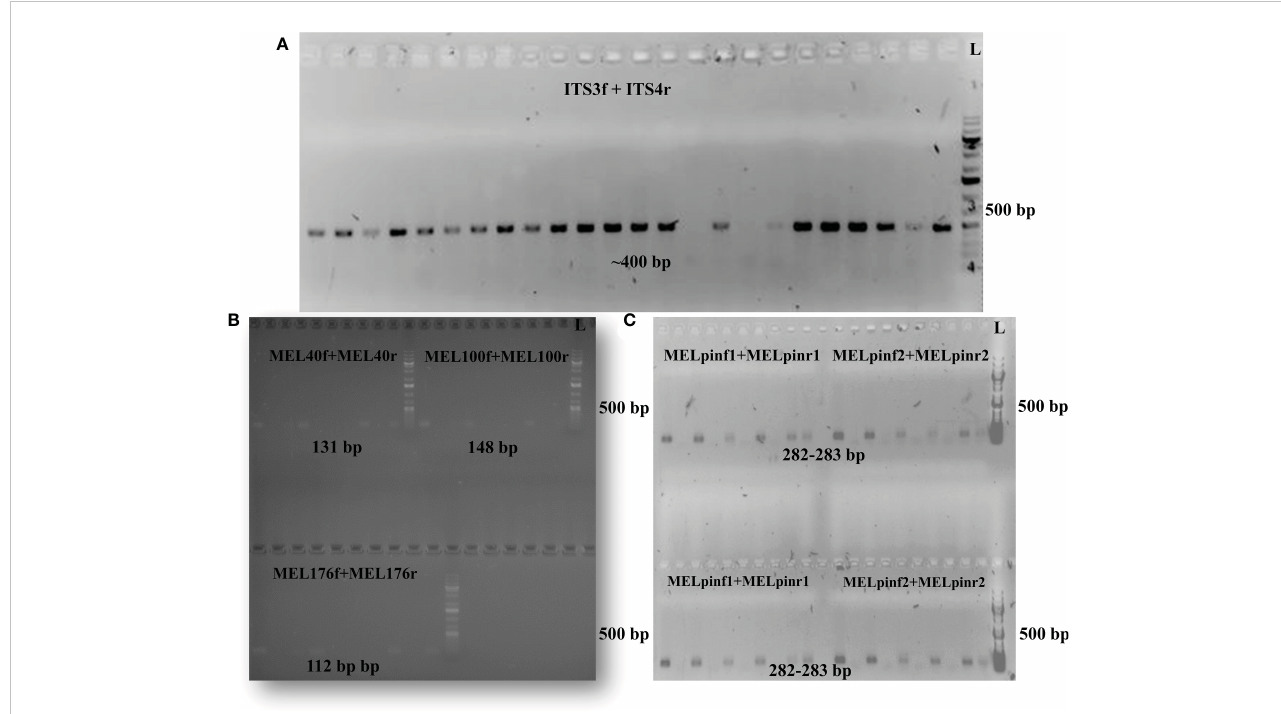
FIGURE 2 Gel images con fi rm the presence of DNA from targeted taxa. (A) Strong bands representing the conserved ITS2 region (using ITS3f+ITS4r primer pairs) con fi rmed the presence fungal rDNA. (B) Ampli fi cations using the MEL40, MEL100 and MEL176 primer pairs detected DNA of the Melampsora genus. (C) Ampli fi cations using the MELpin1 primer pairs with annealing temperatures of 58°C (upper panel) and 60°C (lower panel) con fi rmed the presence of M. pinitorqua. DNA ladder (L) indicates the size of the ampli fi ed PCR